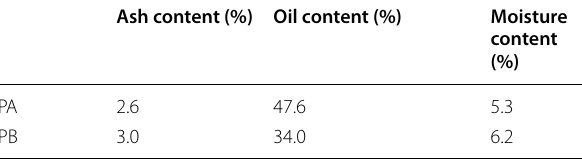
Table 2 Composition of the two peanut additive samples: ash, oil, and moisture contents (mean values of triplicated